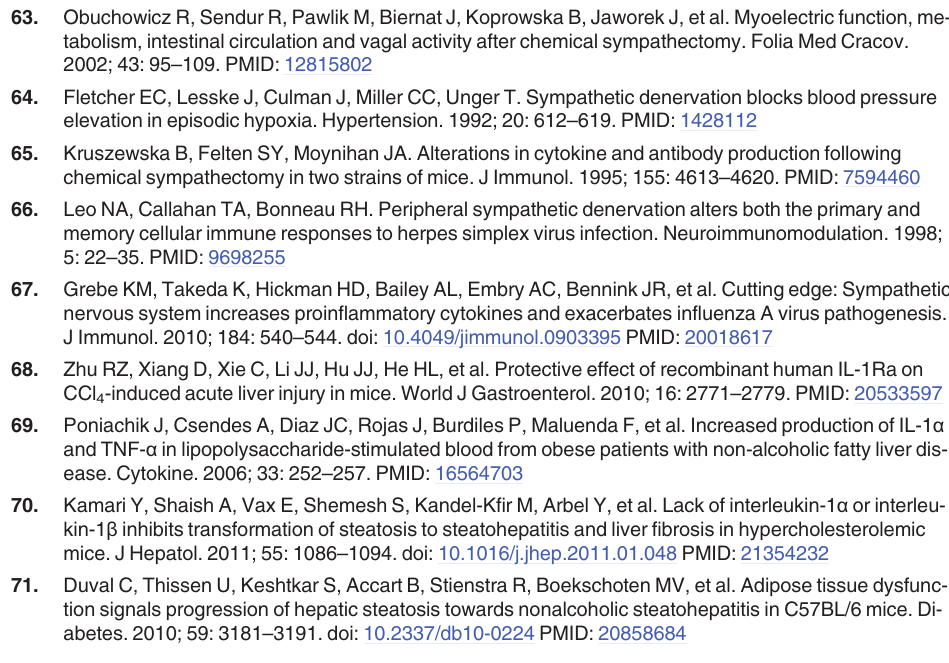
PLOS ONE | DOI:10.1371/journal.pone.0121365 March 23,